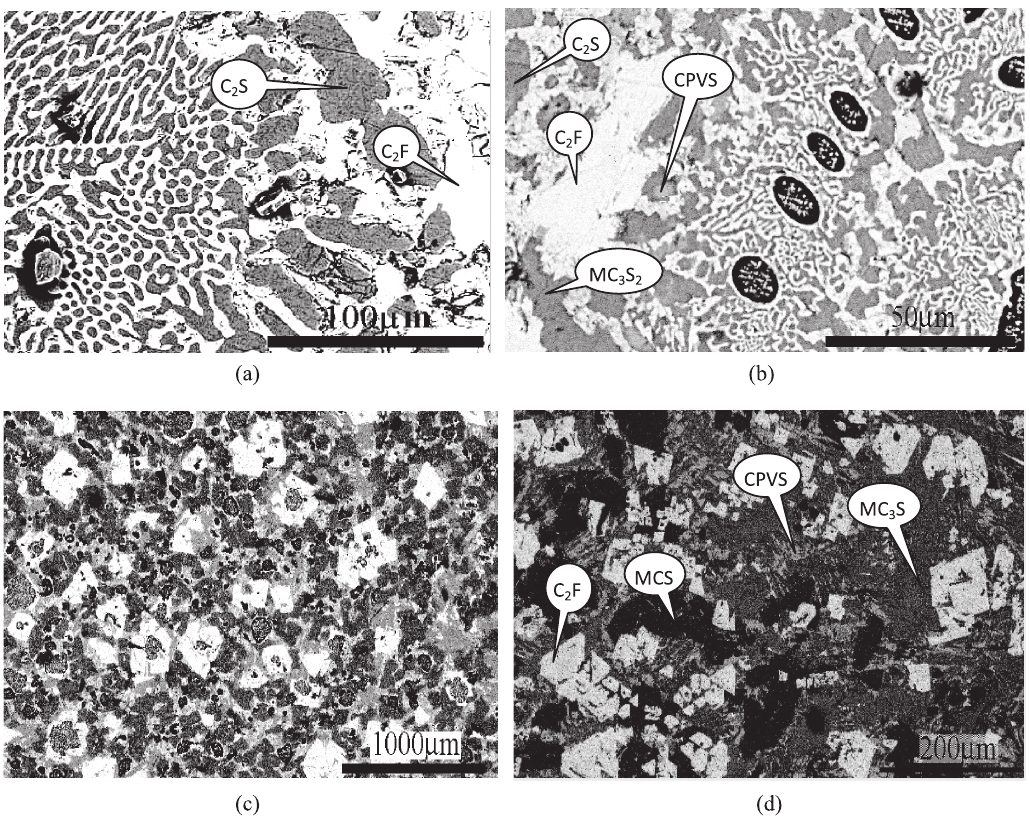
Fig. 2: SEM images of samples 1, 2 and 3. (a) The original slag, (b) the slag + 8% MgO, (c) the slag + 16% MgO (full view), and (d) the slag + 16% MgO (detail).